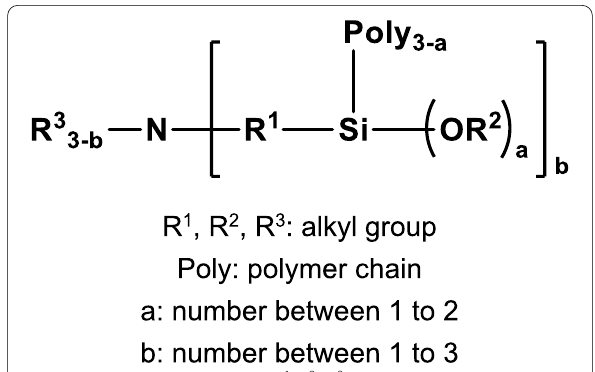
Fig. 2 Functional group B [15]. R 1 , R 2 , R. 3 : alkyl group. Poly: polymer chain. a number between 1 to 2. b number between 1 to